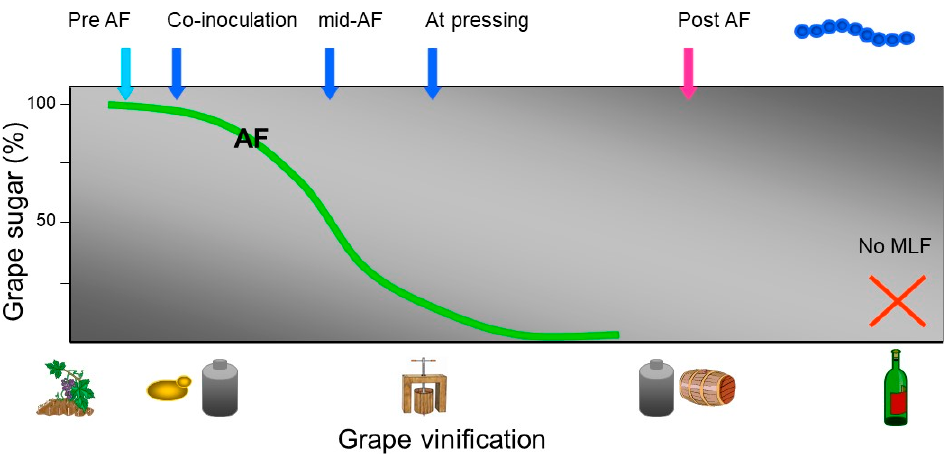
Figure 2. Inoculation regimes for selected wine lactic acid bacteria Adapted from Bartowsky, Australian Wine Research Institute (AWRI), Entretiens Scientifiques Lallemand Dubrovnik 2011.